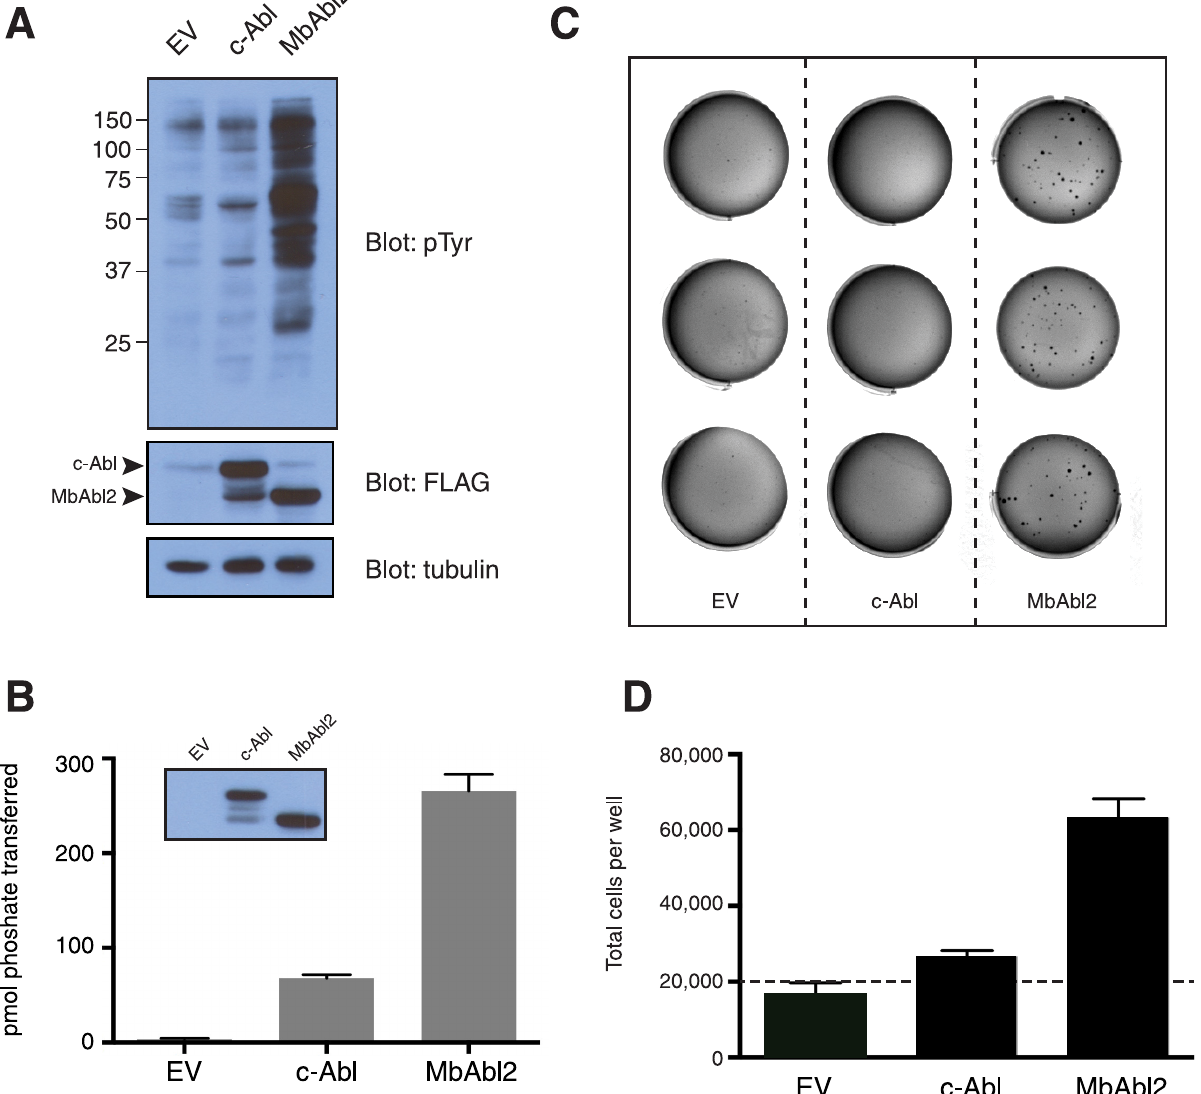
Fig 5. Abl activity in mammalian cells. (A) Lysates from NIH3T3 cells stably expressing Abl, MbAbl2, or empty vector (EV) (100 μ g) were separated by SDS-PAGE and analyzed by anti-pTyr Western blotting. The membrane was stripped and reprobed with anti-Flag and tubulin antibodies to ensure equal loading of Abl and MbAbl2. The figure is representative of three independent experiments. (B) Lysates from NIH3T3 cells expressing Abl-Flag or MbAbl2-Flag (1 mg total protein) were subjected to immunoprecipitation reactions with anti-Flag affinity resin. Duplicate samples of the precipitated proteins were used in an in vitro kinase reaction with Abl peptide and [ γ - 32 P]-ATP. Error bars show standard deviations. A separate sample was analyzed by Western blotting with anti-Flag antibody (inset). (C) Colony formation assay. NIH3T3 cells expressing Abl, MbAbl2, or vector control were sorted for equal GFP expression. Cells (1000 per well) were resuspended in low melting point agarose prepared in complete media. Wells were photographed after 28 days. This experiment was repeated three times with similar results. (D) Anchorage-independent growth assay. NIH3T3 cells expressing Abl, MbAbl2, or vector control (20,000 per well; dashed line) were resuspended in complete media and added to ultra low attachment plates. Cells were counted after 6 days of growth. This experiment was performed three times with similar results. Error bars show standard deviations. colony formation (54.3 ± 4.7 colonies per plate), whereas c-Abl did not (Fig 5C). Next, we mea- sured the growth of NIH3T3 cells expressing c-Abl or MbAbl2 on ultralow attachment plates. The initial number of cells seeded in each well was 20,000. After 6 days, vector-transformed control NIH3T3 cells showed a small decrease in cell numbers, and Abl-expressing cells